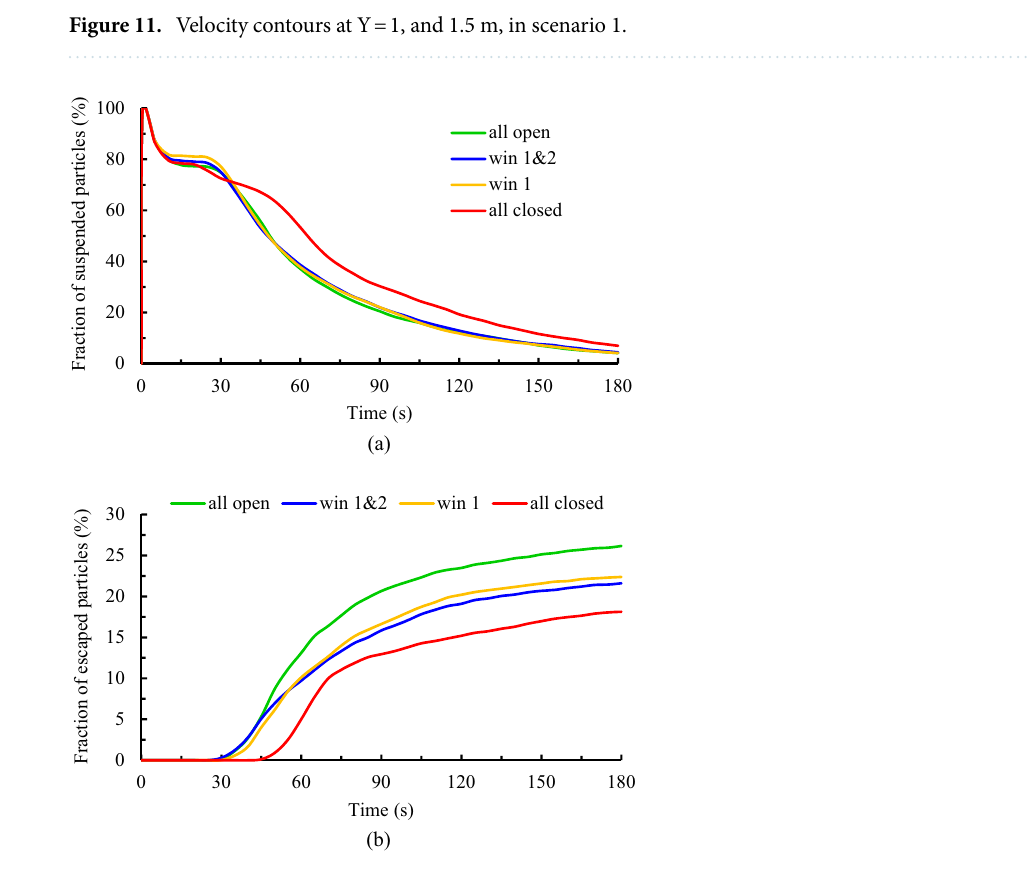
Figure 12. Effects of the exhaust capacity on the dispersion of the particles during various scenarios; ( a ) variation of the suspended particles versus time and ( b ) variation of the escaped particles versus